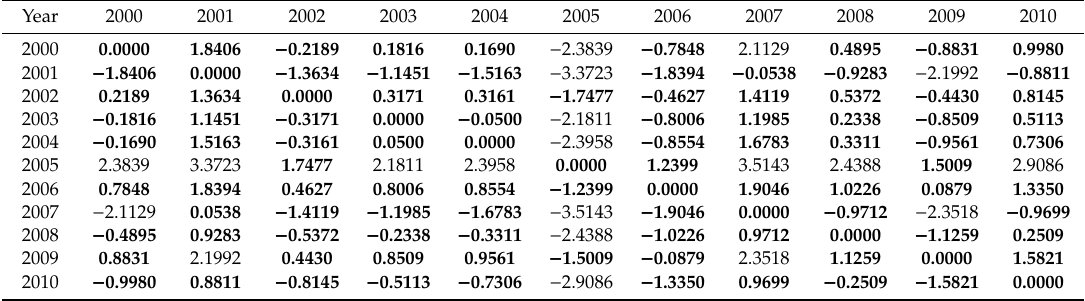
Table A3. Two sample t -test for equal means (equal variances) / Welch’s t -test (unequal variances), bold print if H 0 was accepted at α =